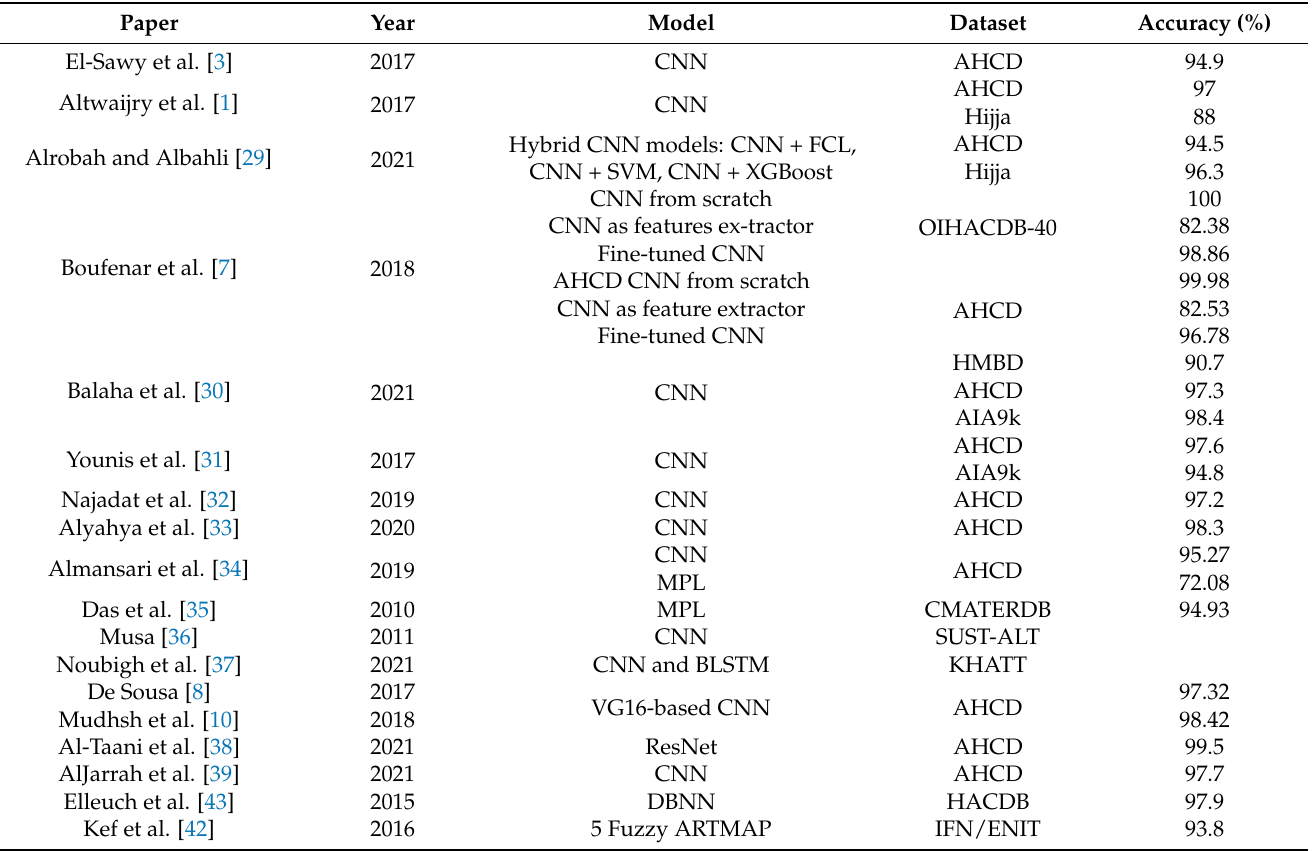
Table 1. Summary of the CNN models for Arabic handwriting recognition.